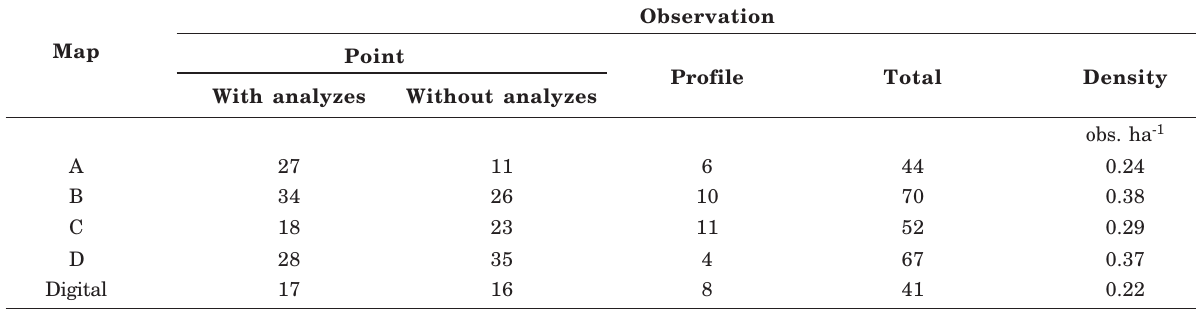
Table 1. Number of observations per soil map